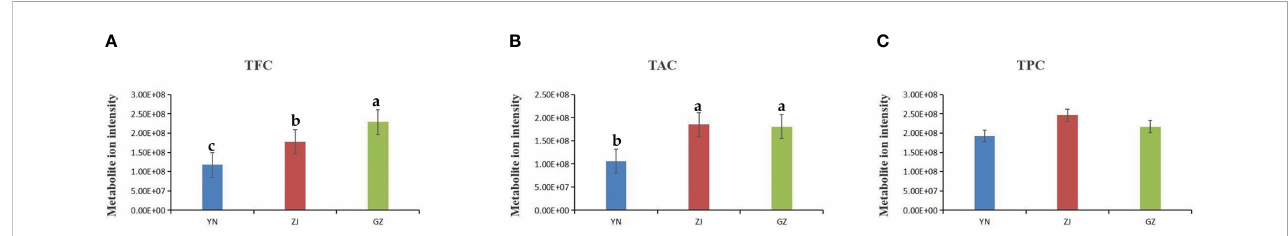
FIGURE 6 Comparison of the total ion intensity of various class of metabolites among stems from YN, ZJ and GZ. (A) TFC, total fl avonoid content, (B) TAC, total alkaloid content, (C) TPC, total phenolic acid content. Different lowercase letters represent signi fi cant